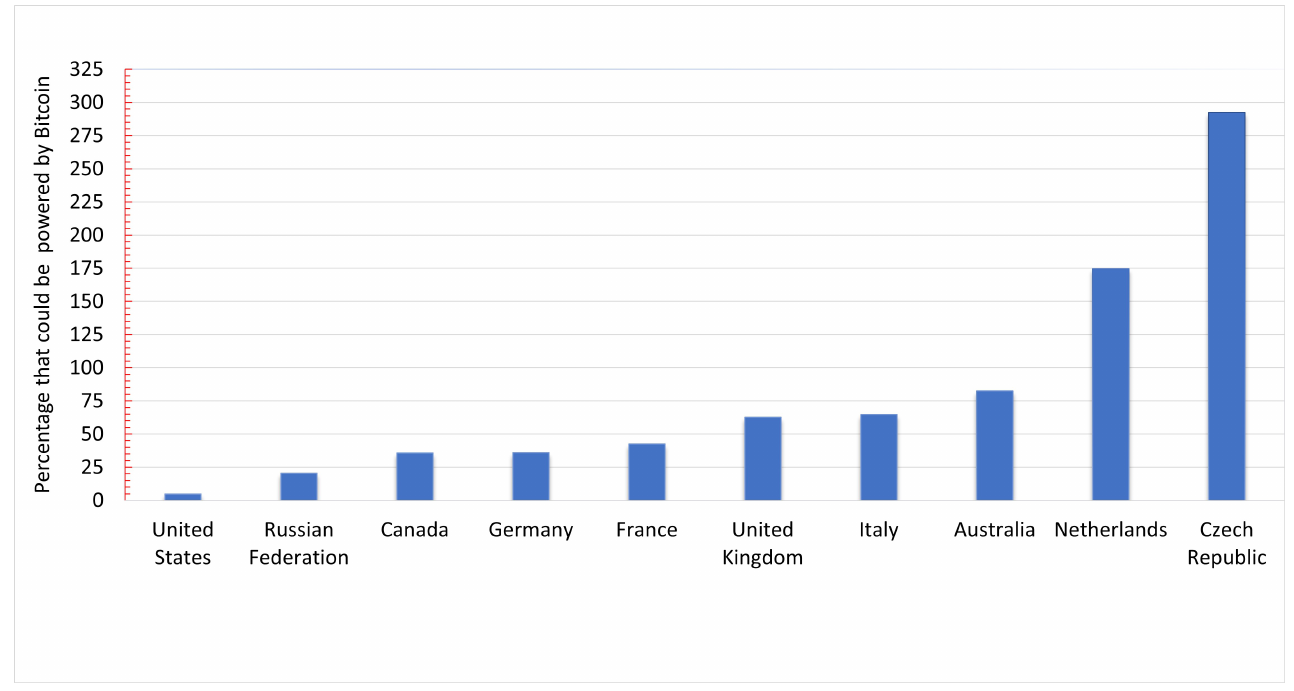
Figure 10. Bitcoin energy consumption relative to many countries (energy consumption of each country according to International Energy Agency and Bitcoin energy index, adopted from https: //digiconomist.net, accessed on 1 January